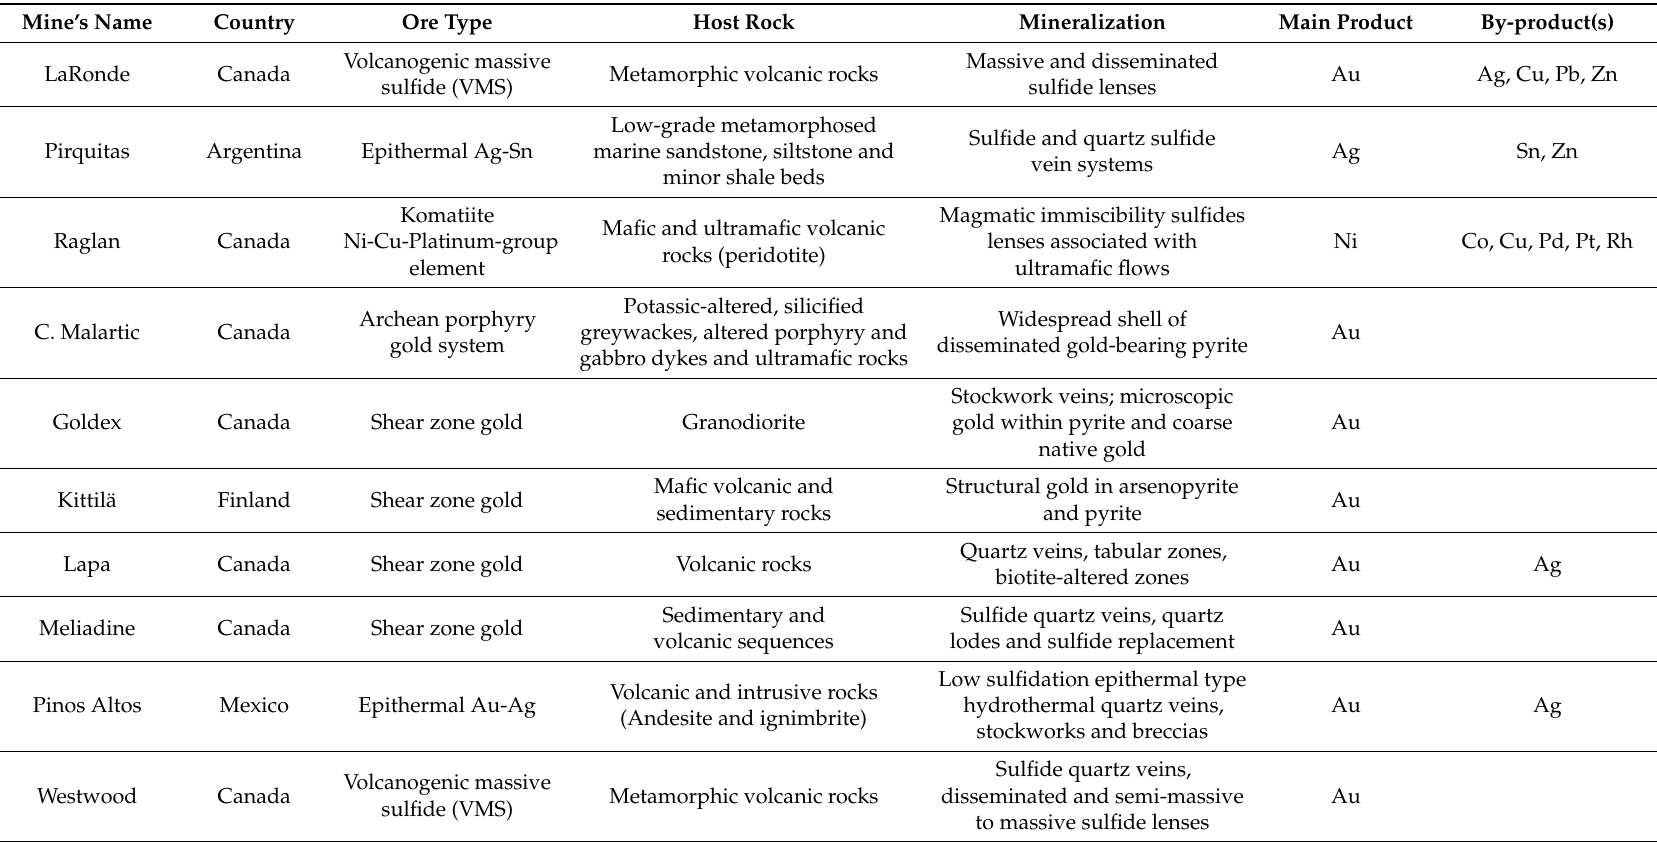
Table 1. Deposits description: country, geology, mineralization, and